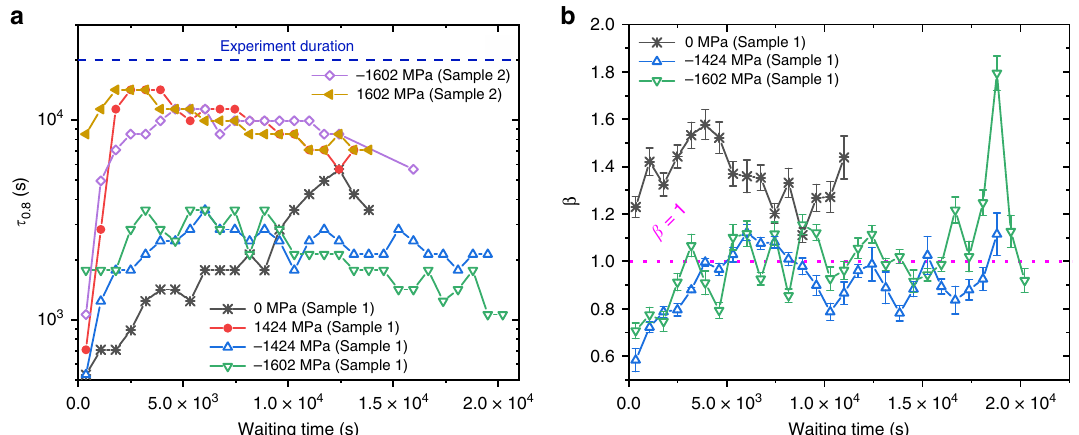
Fig. 4 Time evolution of the relaxation times and shape parameter. a τ 0.8 as a function of waiting time for different stress levels of the studied Zr-based glass. The duration of each XPCS experiment, effectively an upper bound to determining τ 0.8 , is also indicated. b The shape parameter β for momentary relaxation dynamics, with residual standard deviation errors as a function of waiting time for different stress levels. Tensile and compressive stresses are marked by solid and open symbols, respectively. The 0-MPa data are from Sample 1 in a completely